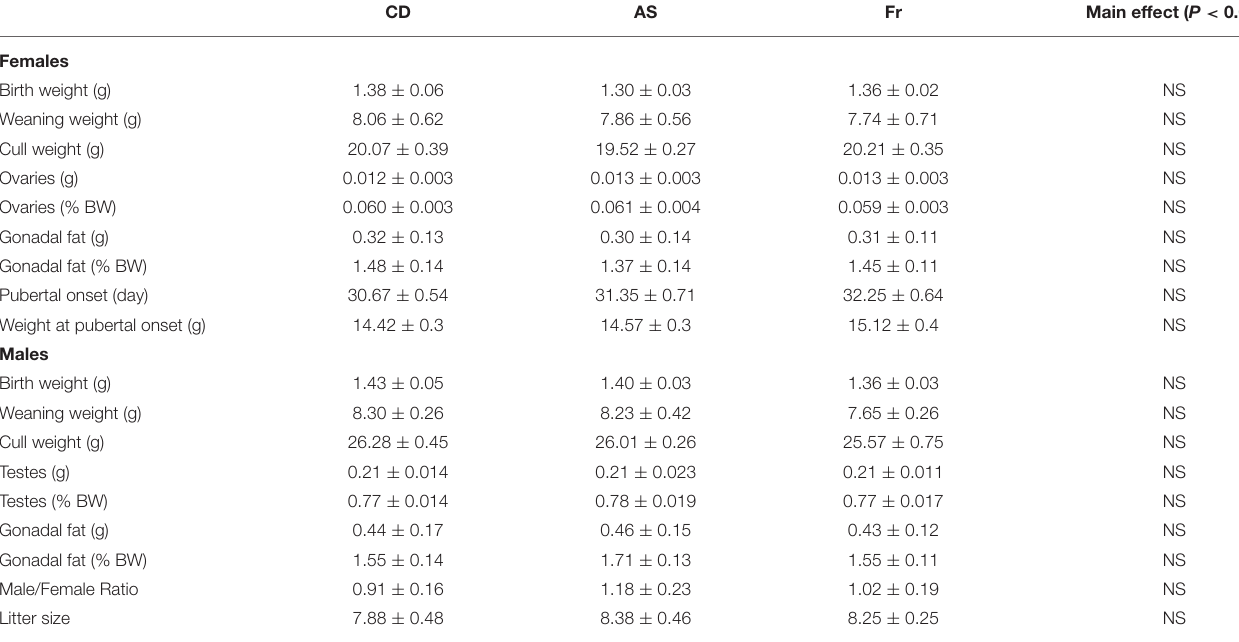
TABLE 1 | Birth, weaning, and cull weight, and gonads and gonadal fat weight of female and male offspring. CD AS Fr Main effect ( P < 0.05)